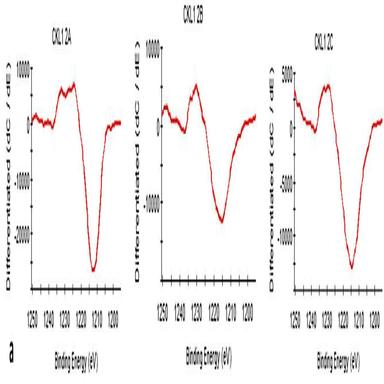
14a. Differentiated C KLL Auger from for Set 2 films; 14b. SP3% calculated in Set2 films by XPS and Raman.